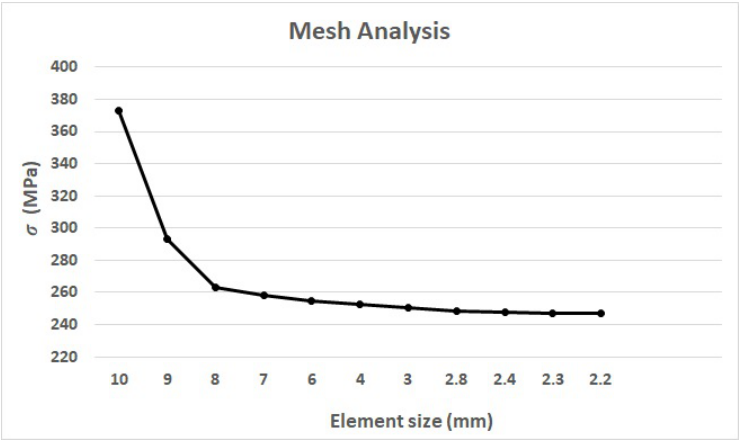
Figure 3. Mesh analysis results between the element size and the maximum equivalent stress ( σ ) of the Exeter